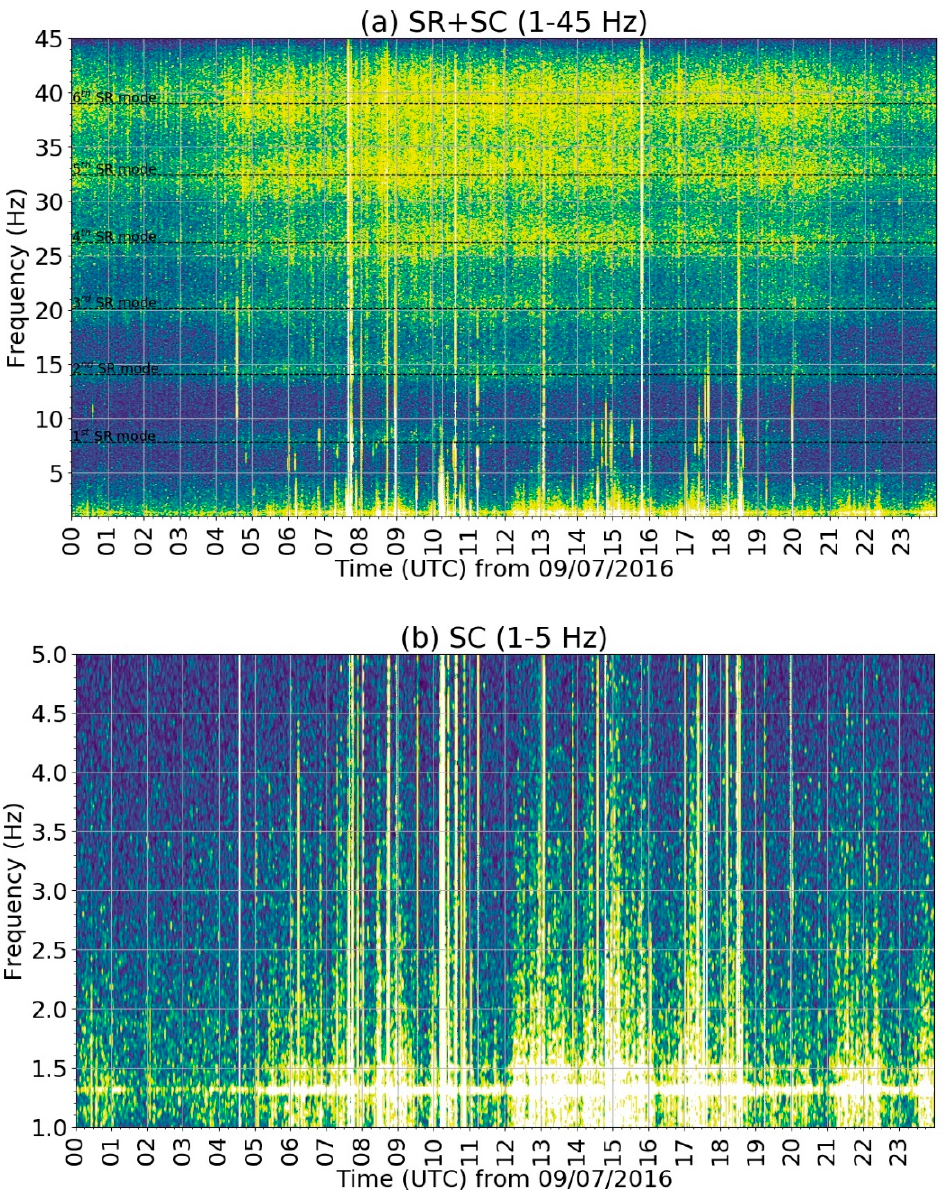
Figure 2. Daily spectrogram of 100 Hz output current from the spherical antenna at Portishead during 6 July 2016, with spectra calculated every 100 s. The major contribution to fair-weather current is given by a combination of turbulent space charge (SC) motion (<5 Hz) and global SR signal (>5 Hz), the latter visible as a series of diffuse horizontal bands corresponding to each SR mode frequency that falls within the antenna range (1–45 Hz) (panel ( a )). Superimposed vertical lines originate from occasional transient local disturbances. Panel ( b ) magnifies the SC effect and indicates that this is at a minimum during late night but largely increases after 0500 UT, hence the need to remove potential data contamination when looking at the SR